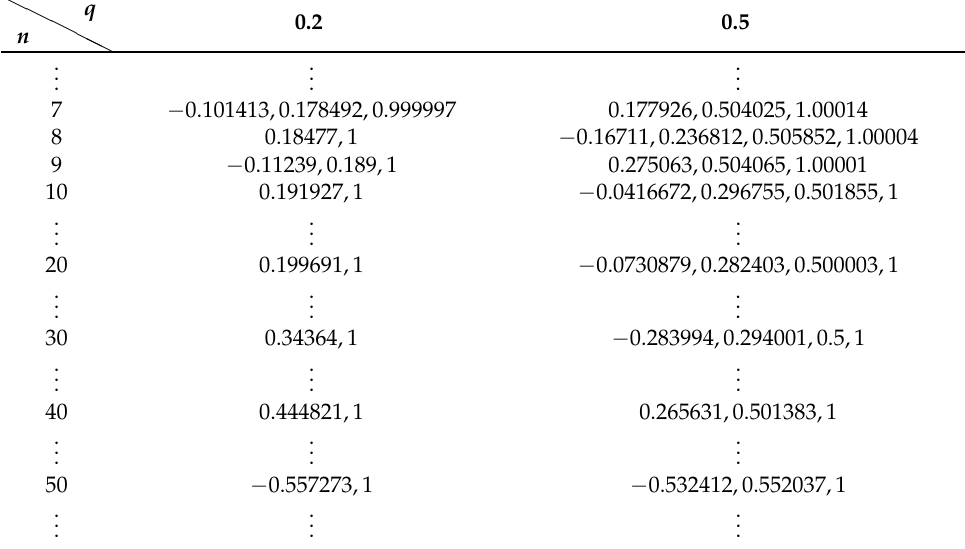
Table 2. Approximate real roots of B n , q ( x )